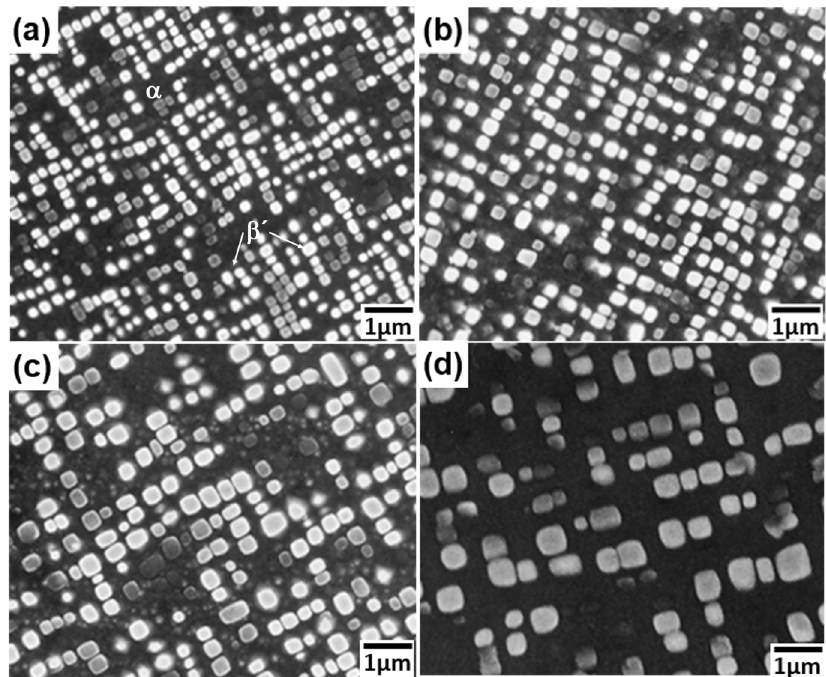
Figure 6. FEG-SEM micrographs of the precipitation evolution for the Fe-10at.%Ni-15at.%Al alloy aged at 850 °C for (a) 10, (b) 25, (c) 50 and (d) 100 h.